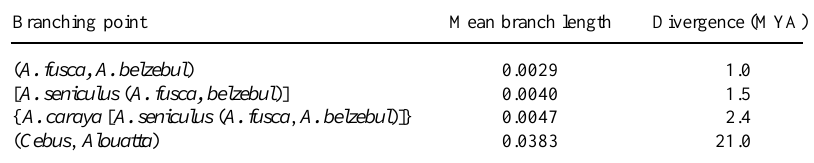
Table II - Local molecular clock estimates of the divergence times of Alouatta species lineages based on the maximum likelihood branch lengths and Goodman’s (1996) estimate of the split between Alouatta and Cebus